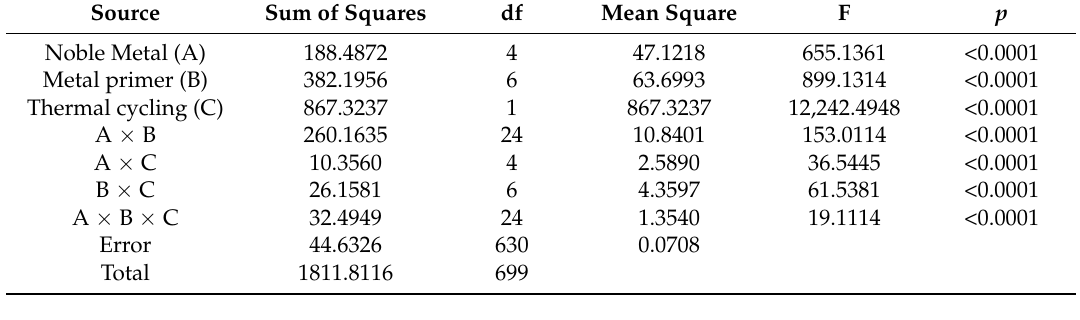
Table 2. Three-way ANOVA results for shear bond strength transformed to square root.